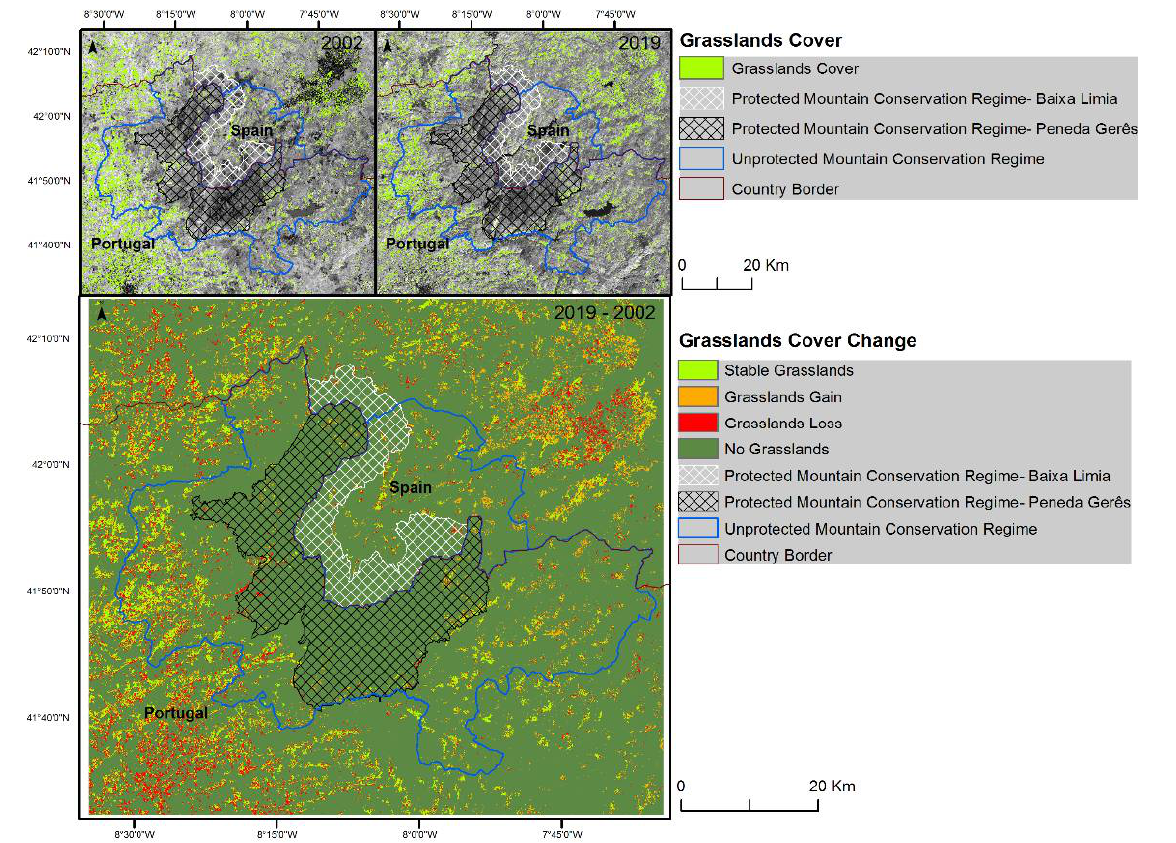
Figure 4. Grassland cover in the study area in the years of 2002 and 2019, and changes in grassland cover (2019–2002), a phase of full European commitment to safeguard mountain grasslands.